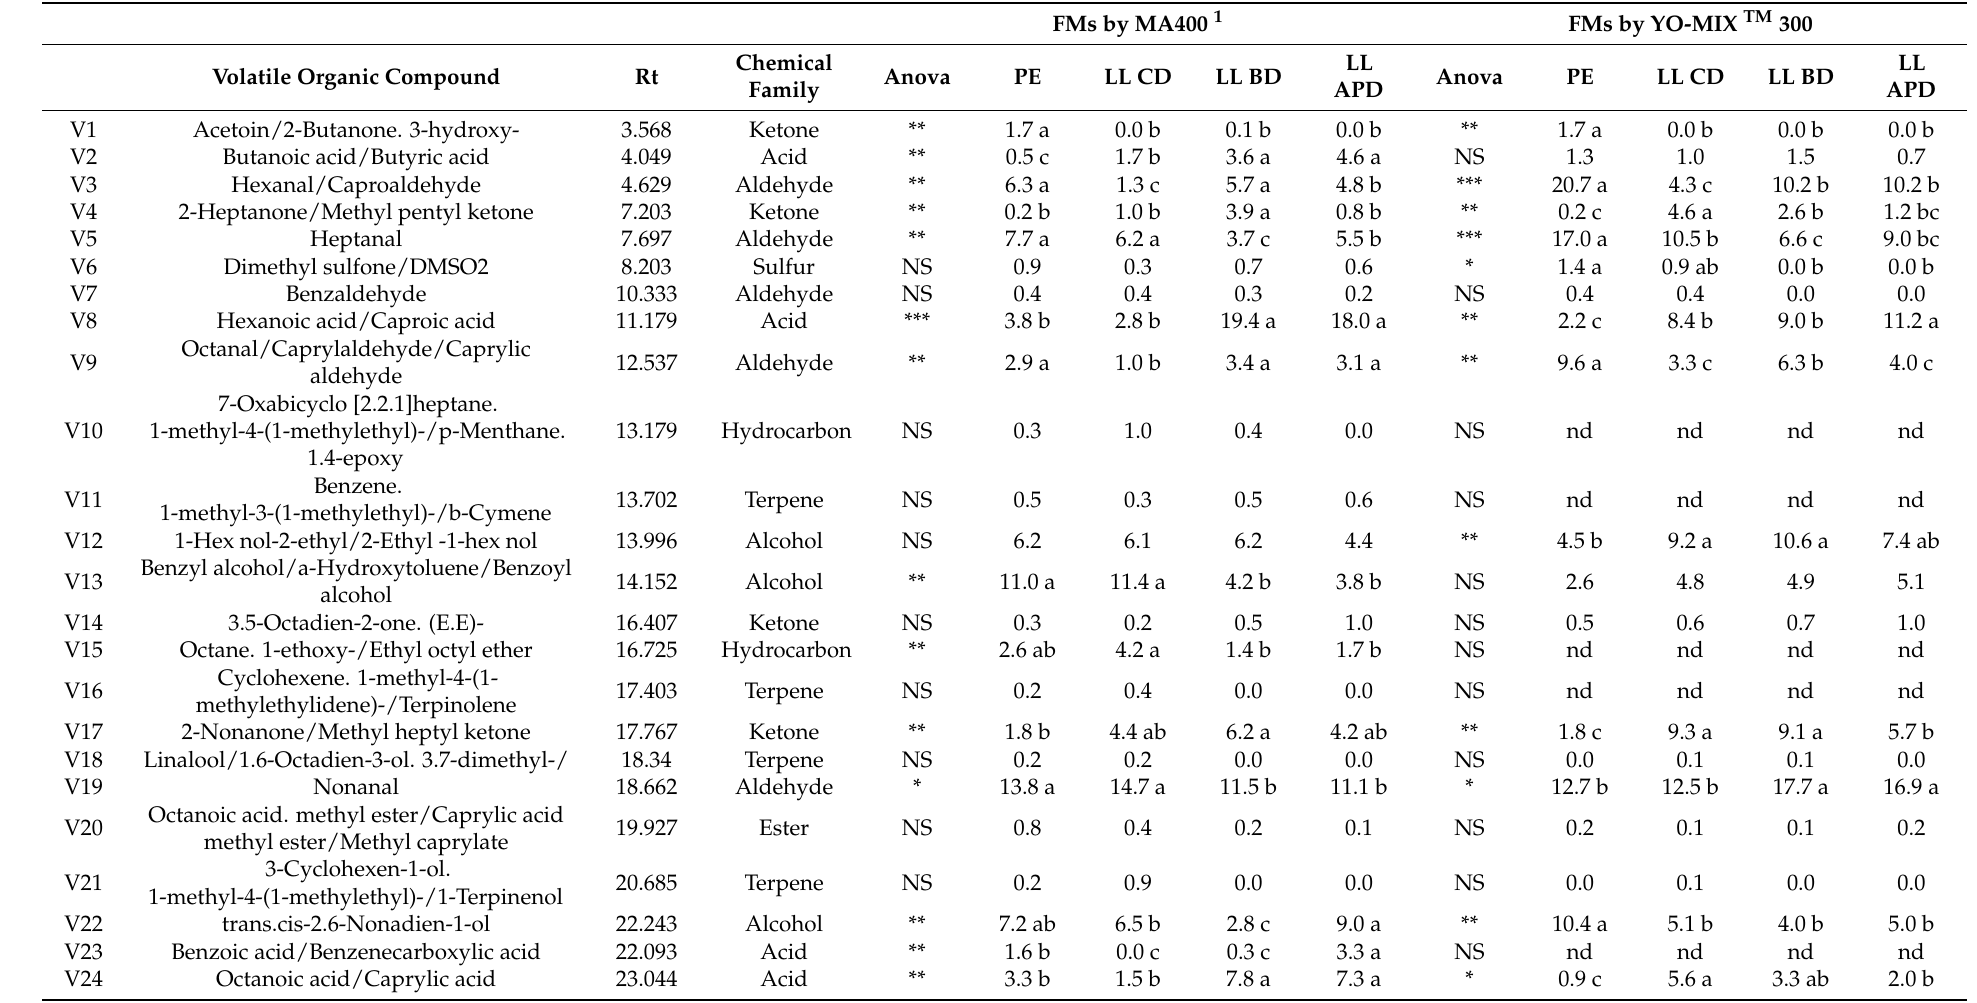
Table 10. Prevalence of the most abundant volatiles (proportion of each individual peak area over total peak area, %) in fermented goat milk by different cultures. FMs by MA400 1 FMs by YO-MIX TM